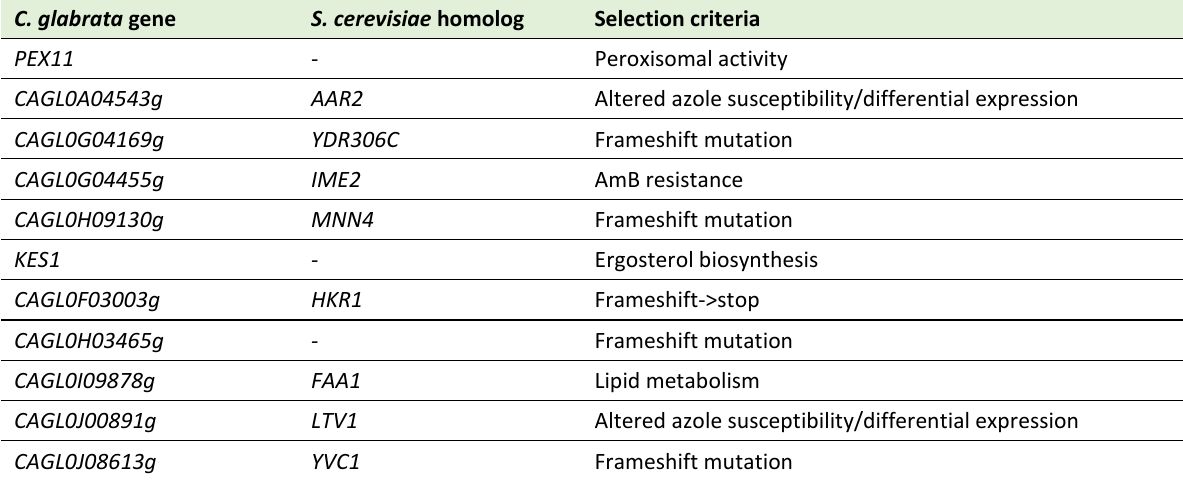
TABLE 5. Genes investigated for a potential role in C. glabrata drug resistance, based on the genome-wide analysis of the azole re- sistant isolates 50570 and